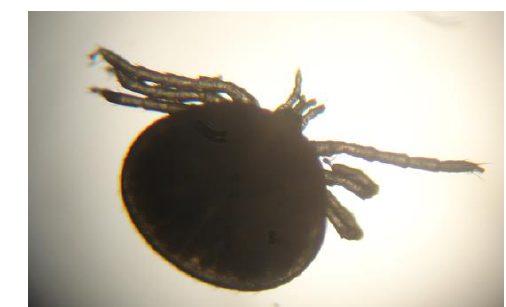
Figure, 2: Larval stage of Argas persicus Helminthes parasites of chickens are prevalent in many parts of the world (21), and prevalence studies